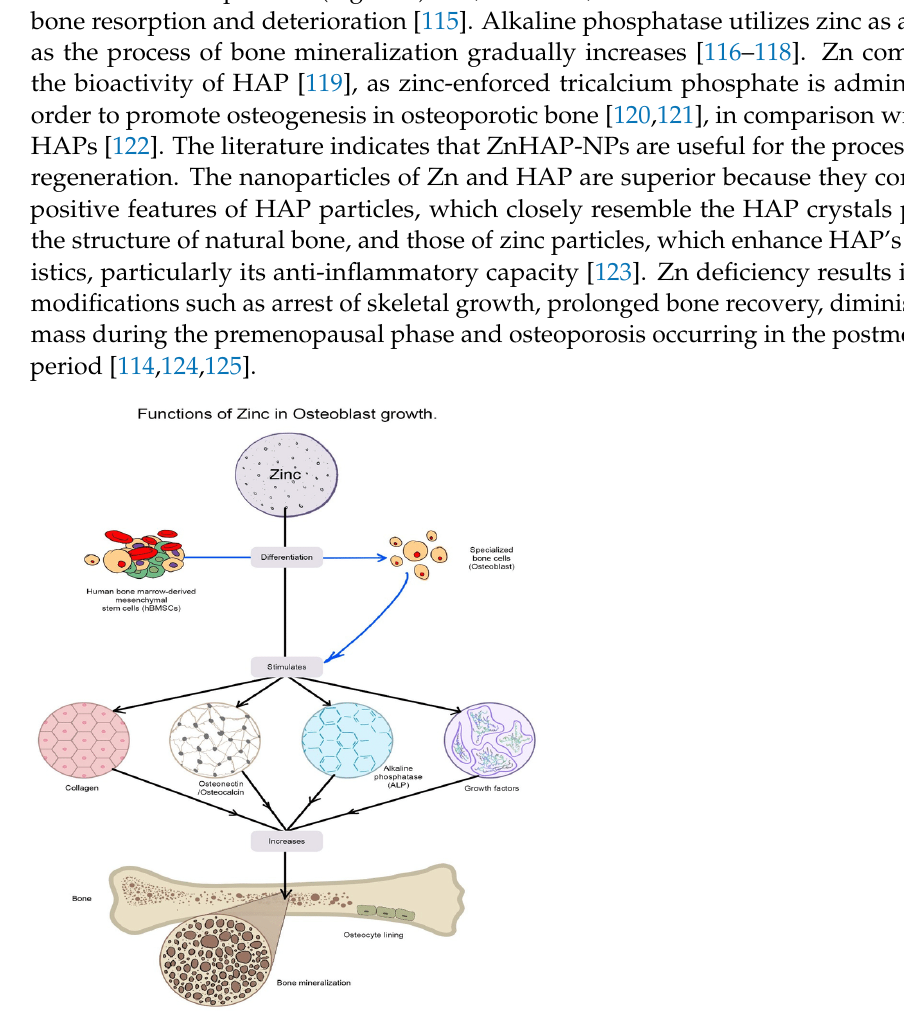
Figure 2. The roles of zinc in osteoblast growth. Zinc stimulates the gene expression of type 1 collagen, osteocalcin and alkaline phosphatase, and increases the production of growth factors in osteoblasts. Reproduced with permission from Mandal, A.K. et al., 2022 [126].